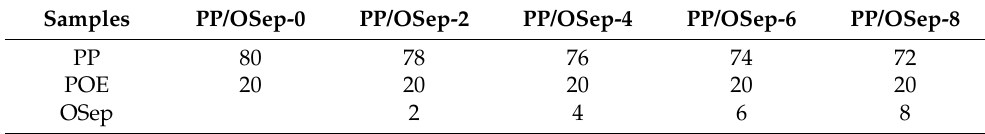
Table 1. Formulation of PP/OSep